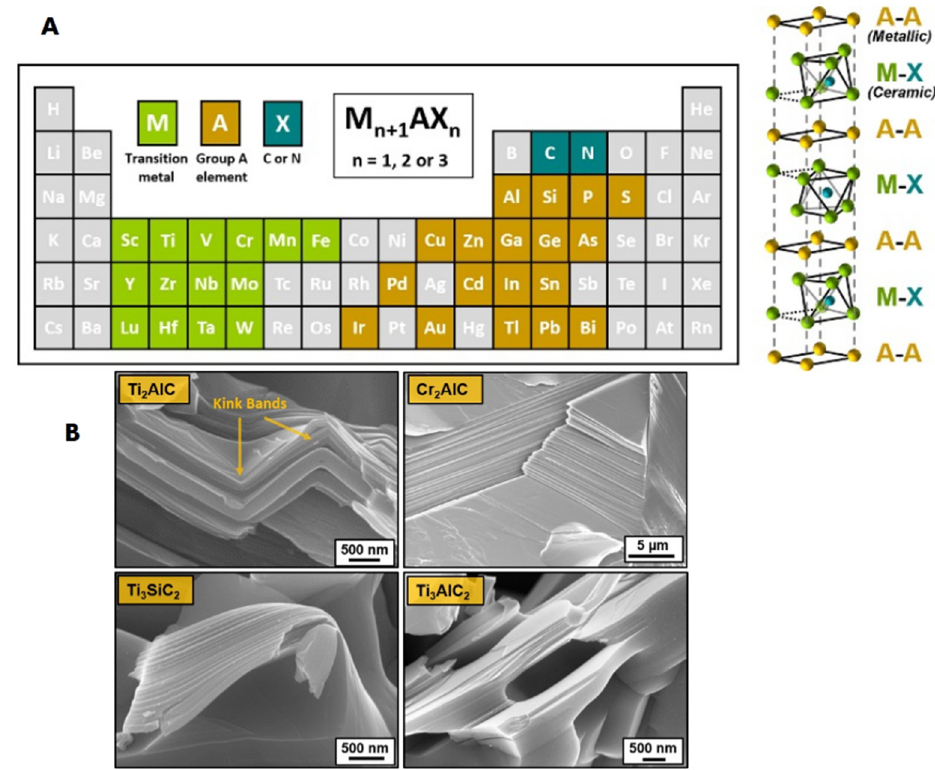
Figure 2. ( A ) MAX phases M n+1 AX n forming elements. ( B ) SEM pictures of the characteristic layered structure and the mechanical response of Ti 2 AlC, Cr 2 AlC, Ti 3 SiC 2 and Ti 3 AlC 2 [39].